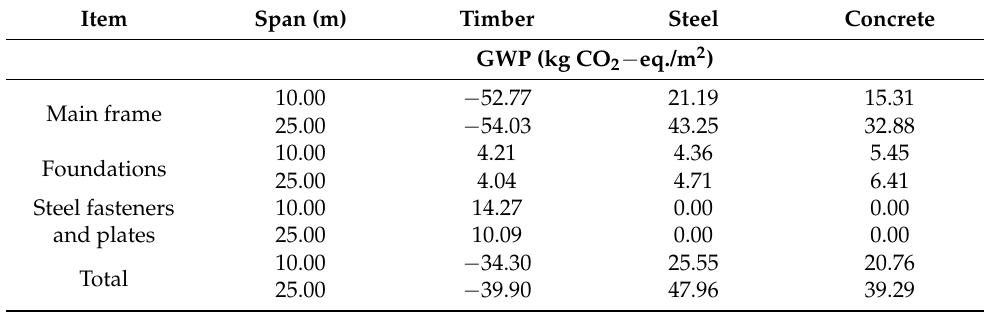
Table 6. GWP/m 2 for all